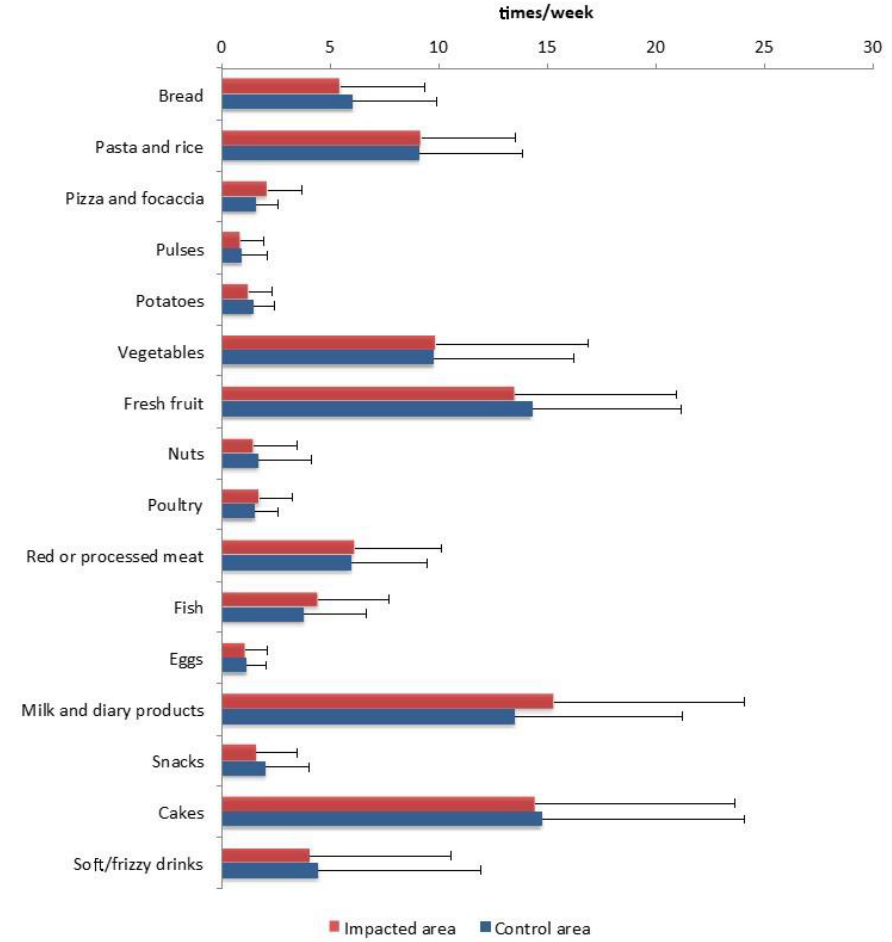
Figure 3. Average weekly consumption of food and beverages, grouped in food categories, by the children living in impacted and control areas. children living in impacted and control